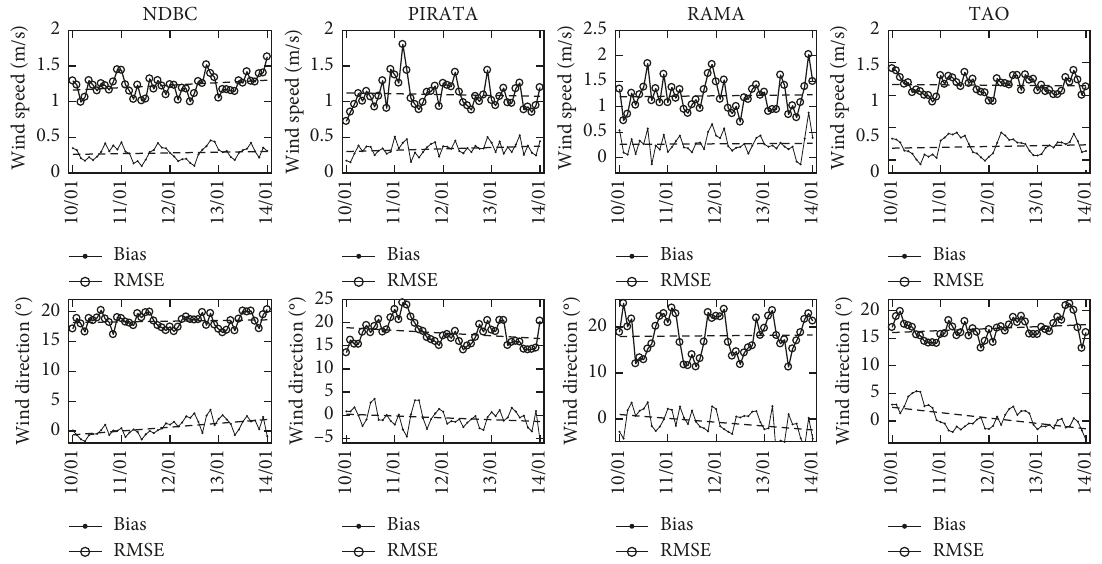
Figure 4: Statistical parameters of wind speed and direction residuals (OSCAT-buoy) at different